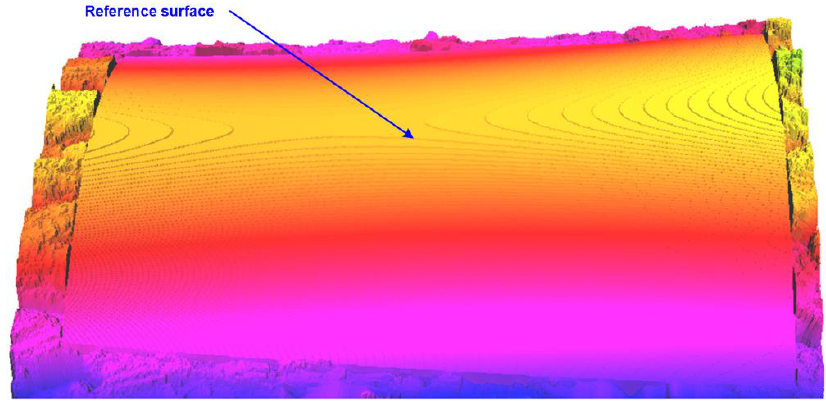
Figure 8. The fourth step in the analysis of the oak bark surface: the determination of a reference surface in a selected tract measuring 120 × 180 mm.